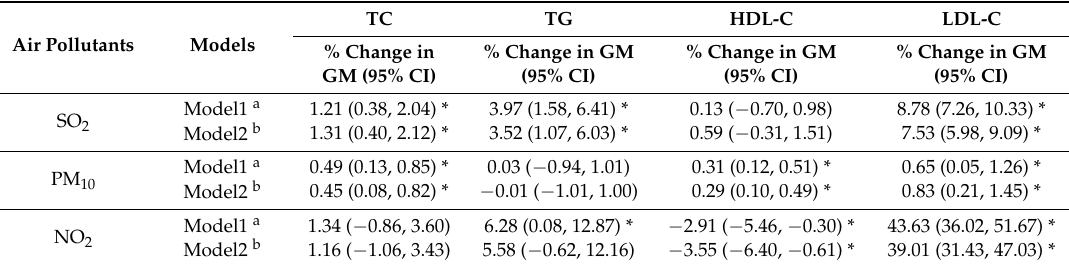
Table 2. Percent change in geometric mean (GM) of TC, TG, HDL-C and LDL-C per 10 µ g/m 3 increase in air pollutants among type 2 diabetes